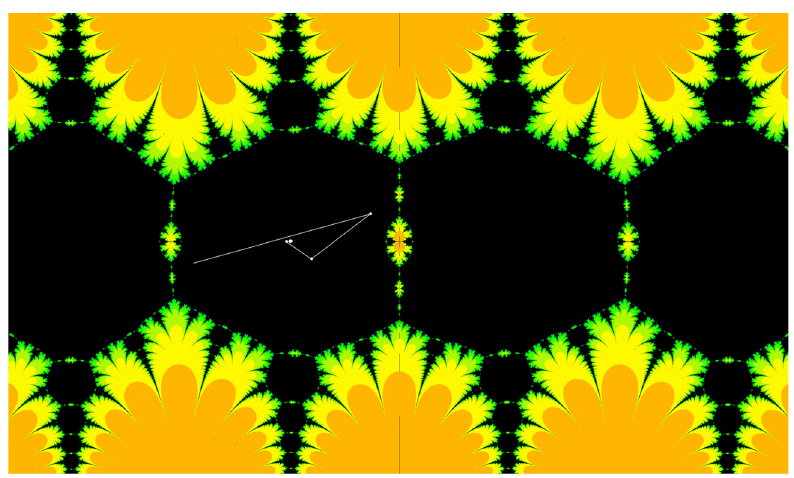
Figure 7: The Fatou set in black, the Julia set in yellow and the orbit of a point in the super - attracting domain D − in